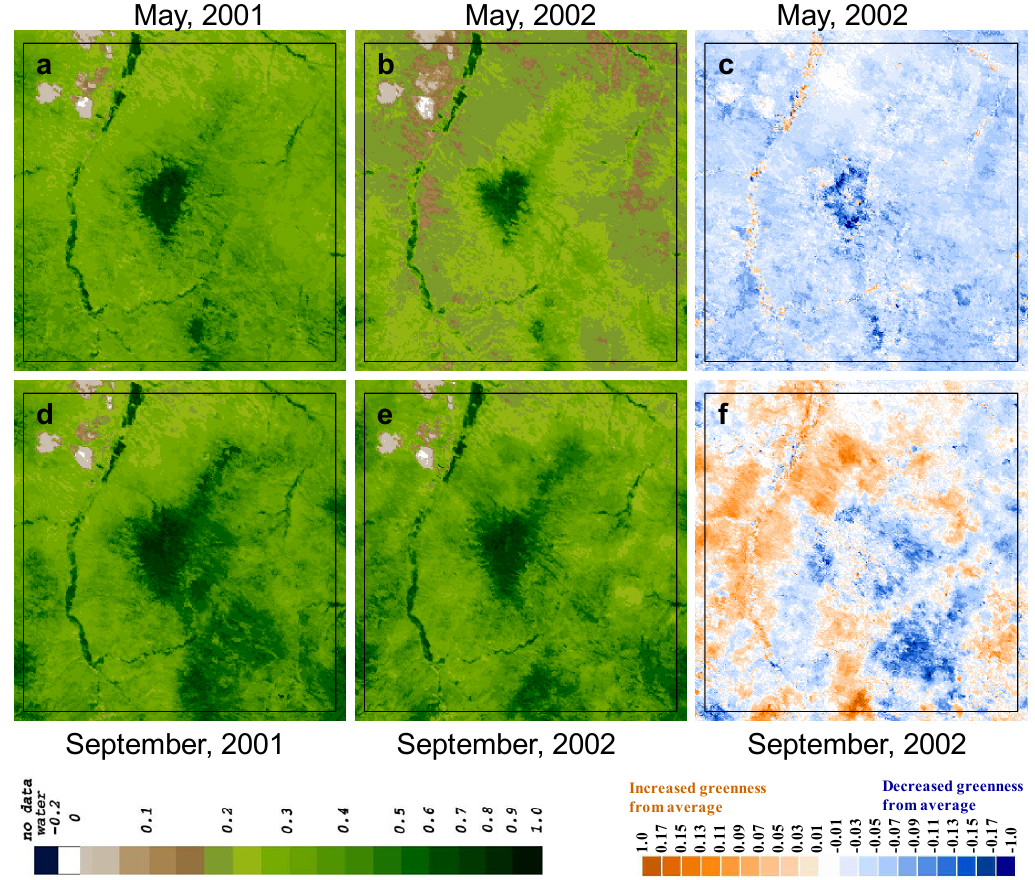
Figure 4. Pre-monsoon (May; 4a–4c) and post-monsoon (September; 4d–4f) NDVI images for a wet year (2001) and a dry year (2002, especially in the spring). The difference from a multiyear NDVI average for May and September highlight below-average NDVI values (blue) for most of the study area in May, 2002. Some of the lower elevation areas show increased greenness patterns during the 2002 monsoon season (September 2002; orange patterns). Curvilinear spatial patterns represent riparian